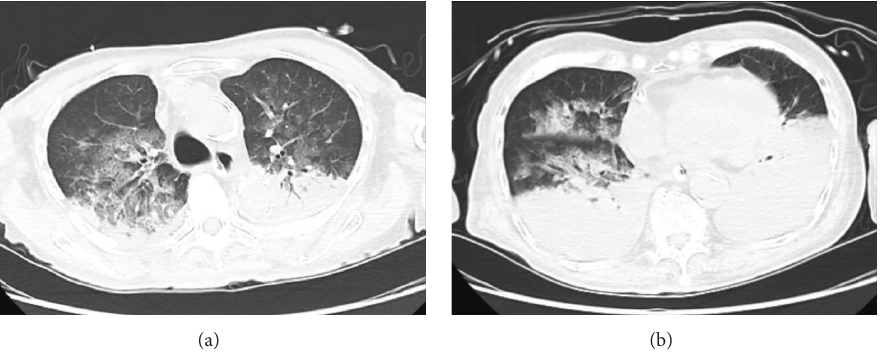
Figure 2: A thoracic computed tomography scan demonstrated bilateral parenchymal consolidation in gravity-dependent areas and ground glass-appearing opacities of lung parenchyma (a). Bilateral atelectasis was observed in the lower lung fields